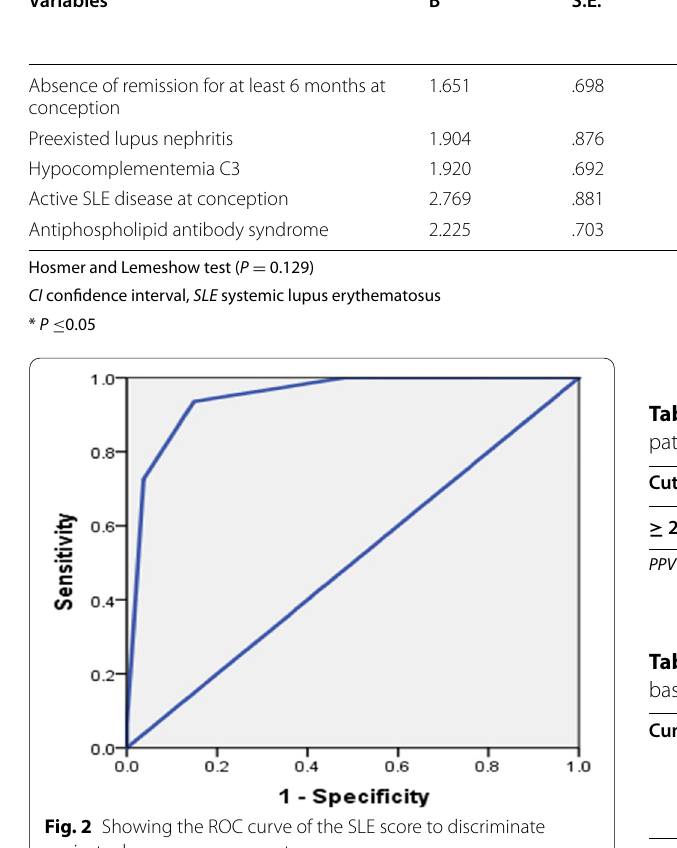
Table 5 Multivariate analysis for the prediction of adverse pregnancy outcomes in lupus patients